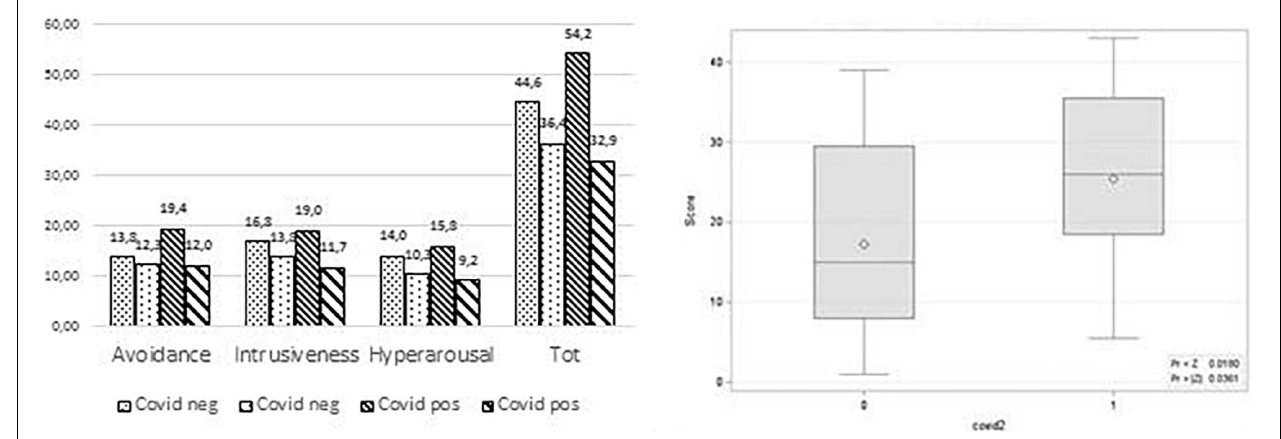
FIGURE 2 | Left: Second wave HCW positive and negative to COVID pre-post treatment scores. Right: Wilconox score distribution of subscale avoidance HCW pre-post treatment COVID